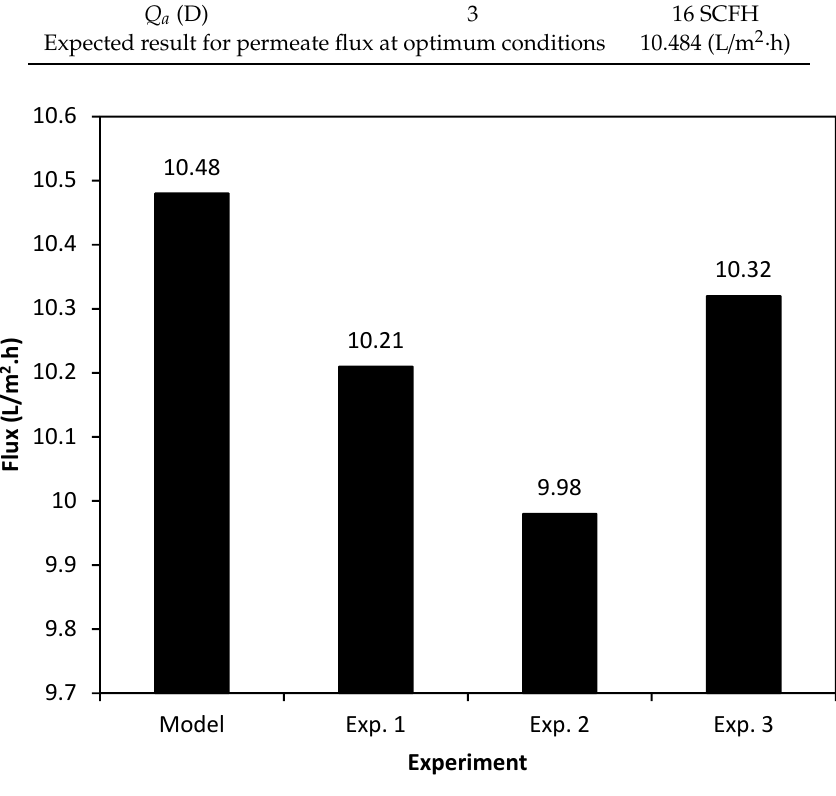
Figure 5. The average permeate flux based on the results of the Taguchi model and experiments after 8 h under the optimum operating conditions ( T h : 65 °C, Q h : 200 mL/min, C : 10 g/L, and Q a : 16 SCFH).